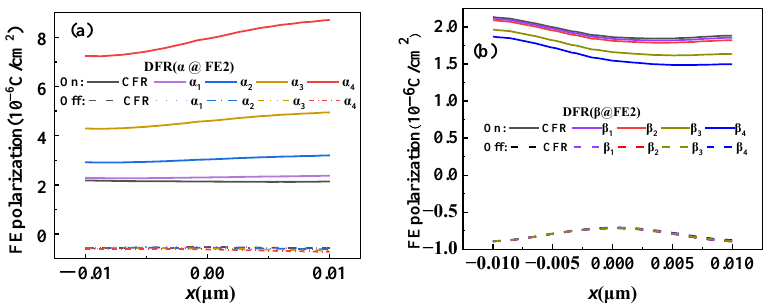
Figure 6. On/Off state ferroelectric polarization intensity distribution along the bottom of the ferro- electric region for the CFR-NCFET and DFR-NCFET with ( a ) variable α in FE2 region, ( b ) variable β in FE2 region. Figure 5. Electron concentration distribution on the channel surface of the CFR-NCFET and DFR-